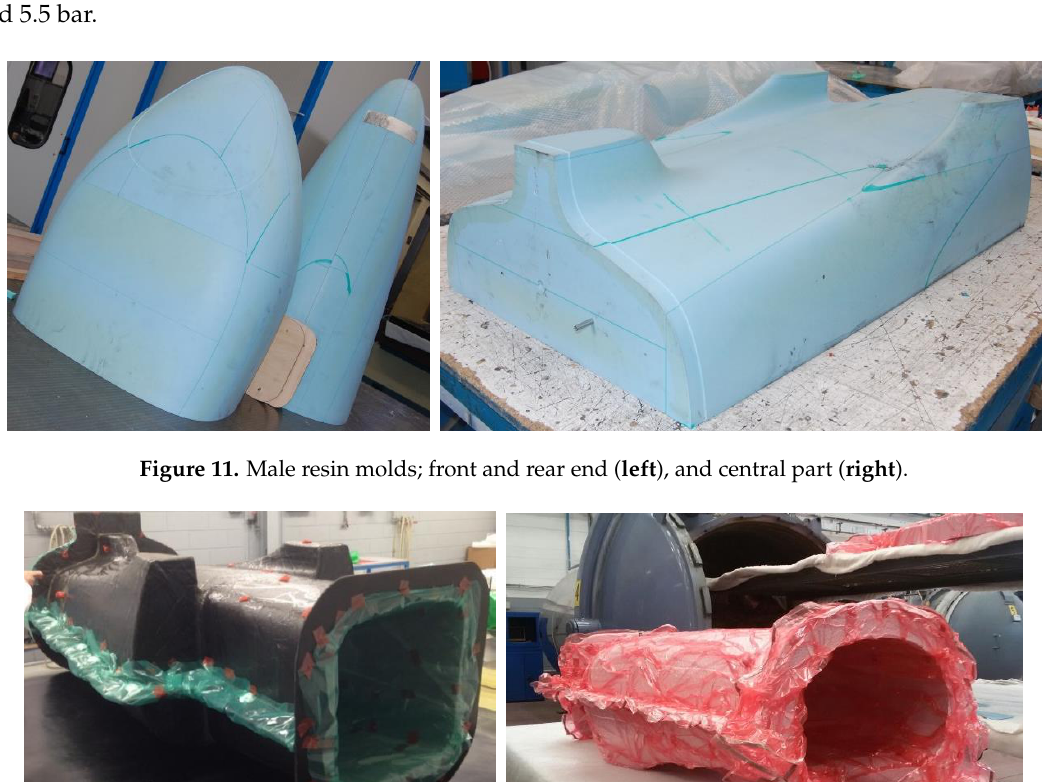
Figure 13. Second lamination in the central part: Nomex honeycomb ( left ) and composite layers ( right ) .